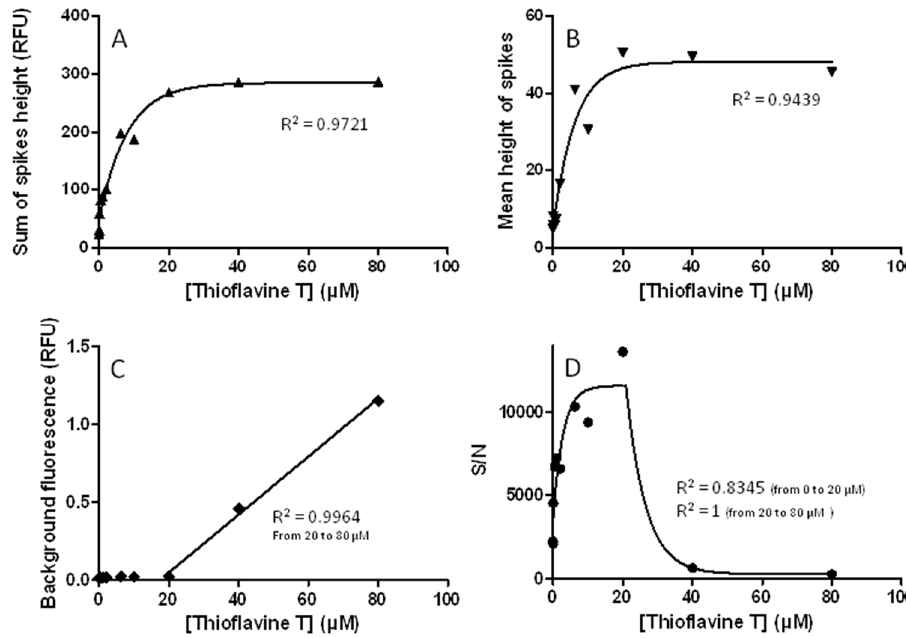
Figure 4. Effects of thioflavine T concentration in the running buffer on: ( A ): the sum of spike heights; ( B ): the mean height of spikes; ( C ): the background fluorescence and ( D ): the signal/background ratio. A β 1-40 incubated for 20 days in saline. Running buffer: 50 mM pH 3.0 citrate buffer containing thioflavine T in the 0.01 µM to 80 µM range. Injection 0.5 psi/80 s. Curve fitting: ( A , B ): non-linear fitting, one phase association; ( C ): linear regression; ( D ): non-linear fitting, one phase association (from 0 to 20 µM) and non-linear fitting, one phase decay (from 20 to 80 µM).